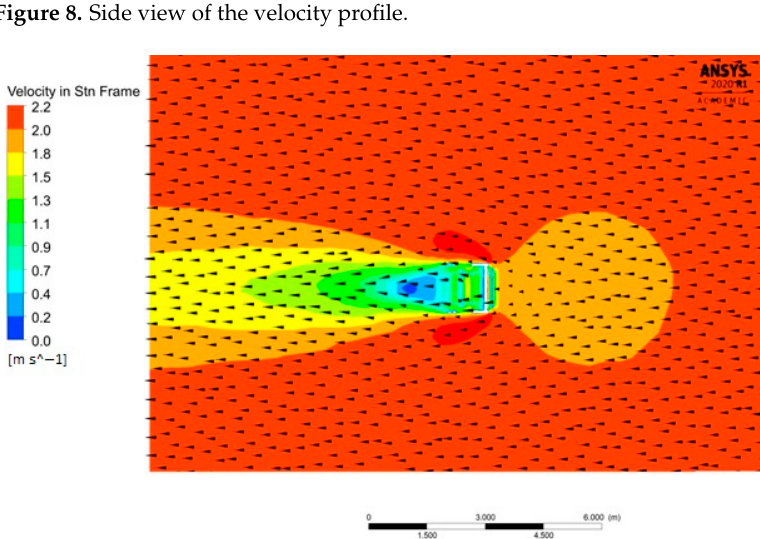
Figure 10. Side view of the pressure profile. 3.1.2. Variation of the Number of Blades and the Inflow Velocity In this section, we consider a variation of inflow velocity and number of blades for the Open-Chain ECB. The results are summarized in Table 2 below. Table 2. Result summary I for Open-Chain ECB (red color is one of the optimum variants which is mentioned later in the conclusions). Design